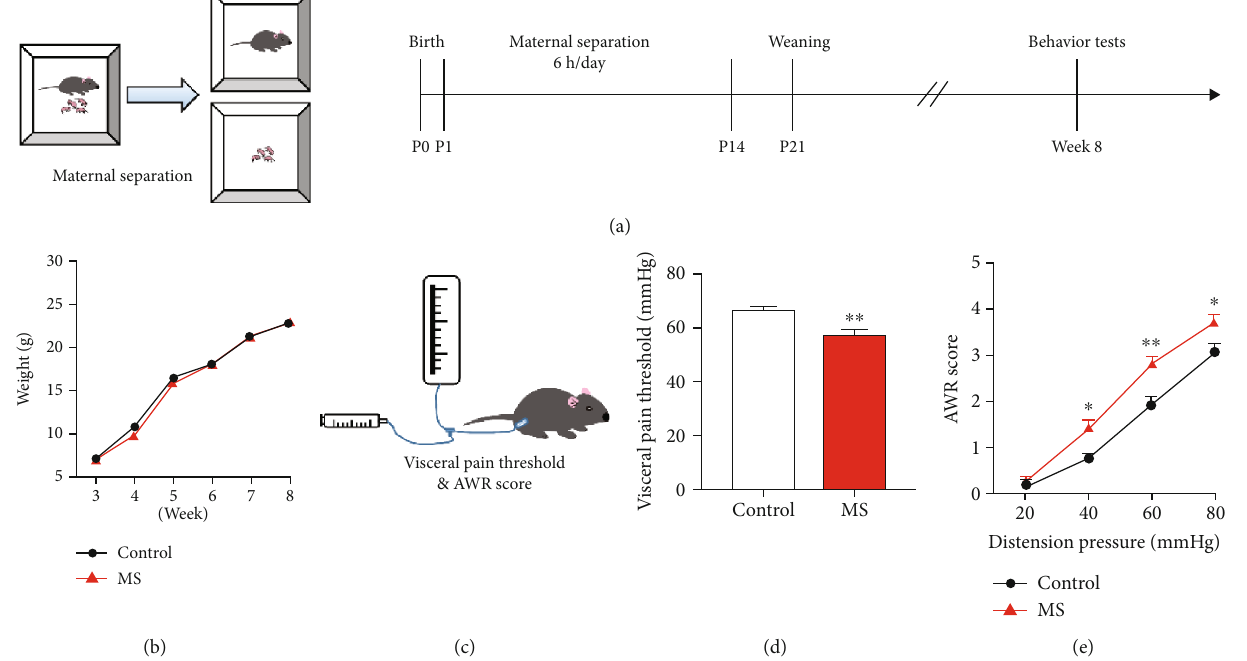
Figure 1: Mice undergoing neonatal MS exhibited visceral hypersensitivity. (a) Experimental paradigm of the maternal separation. (b) There was an insigni fi cant di ff erence in body weight between control and MS mice within 5 weeks after weaning (two-way ANOVA test, F ð 1, 22 Þ = 0 : 51 , P = 0 : 482 , n = 12 per group). (c) Schema of assessment of abdominal withdrawal re fl ex (AWR) and visceral pain threshold. (d) The visceral pain threshold of mice experiencing neonatal MS presented a signi fi cant decline ( t -test, t = 3 : 11 , P < 0 : 01 , n = 12 per group). (e) The AWR score displayed a signi fi cant increase in MS mice subjected to pressure stimuli at 40 mmHg (Bonferroni post hoc test, P < 0 : 05 ), 60mmHg (Bonferroni post hoc test, P < 0 : 01 ), and 80 mmHg (Bonferroni post hoc test, P < 0 : 05 ), respectively (two-way ANOVA test, F ð 1, 22 Þ = 9 : 82 , P < 0 : 01 , n = 12 per group). Data are expressed as mean ± SEM ; ∗ P < 0 : 05 and ∗∗ P < 0 : 01